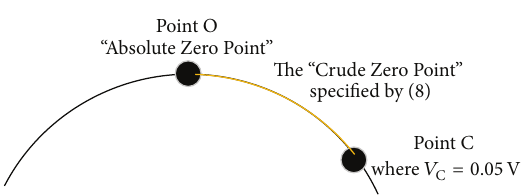
Figure 2: The relationship between “Absolute Zero Point” and “Crude Zero Point.”